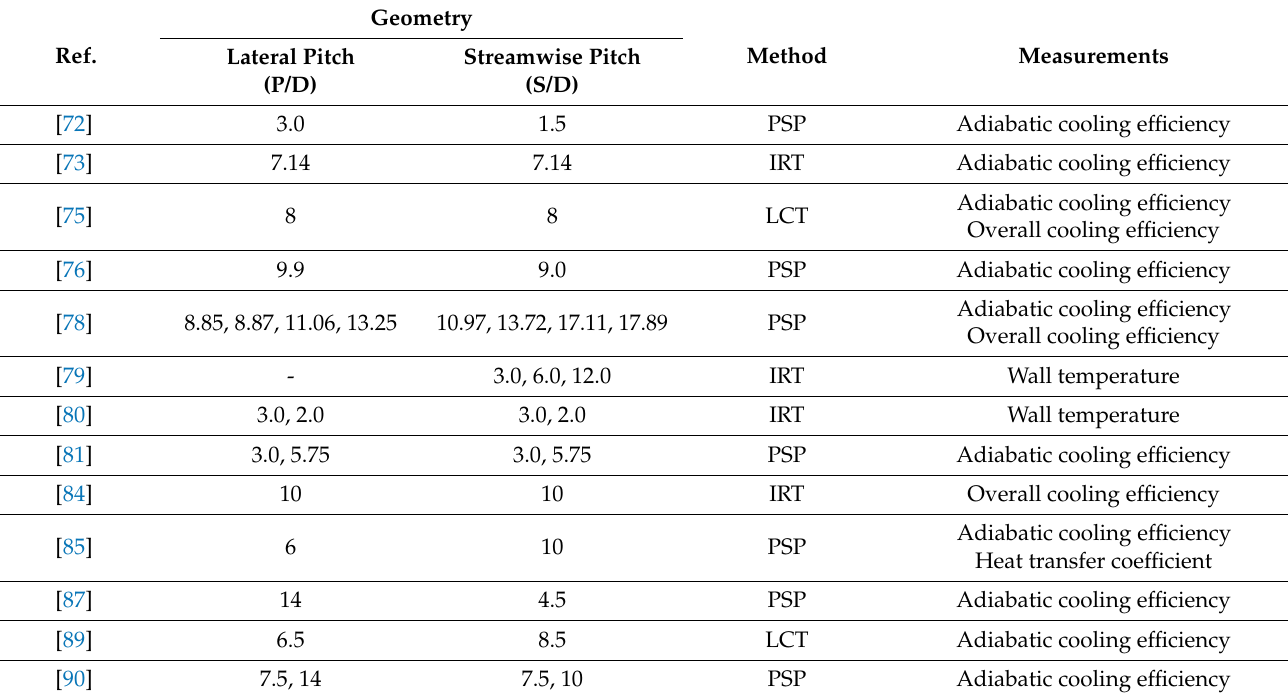
Table 2. Experimental studies of effusion